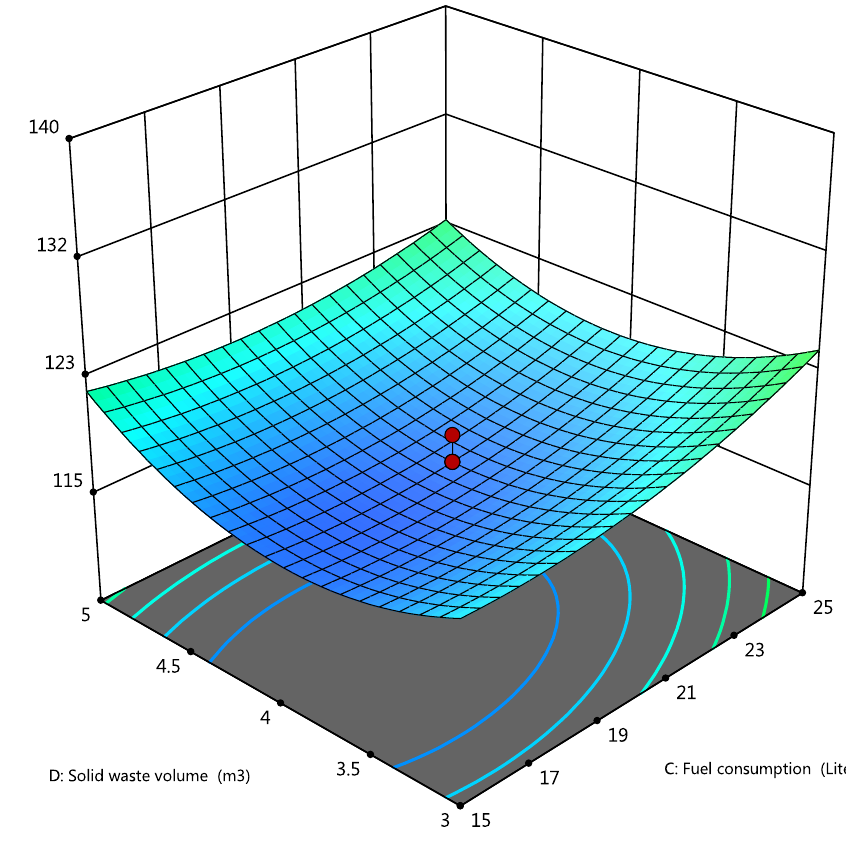
Figure 4. 3D surface plots showing the dependency of the volume of solid waste collected (m 3 ) and Fuel consumed in liters during collection on the cost of the solid waste management system (Design-Expert software v.